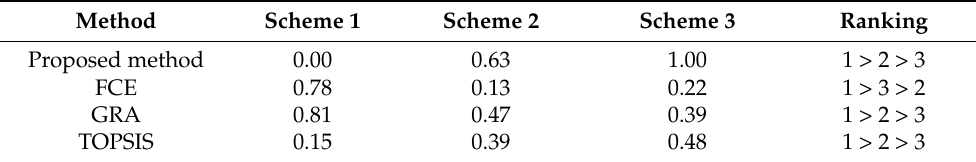
Table 5. Evaluation results using different methods.